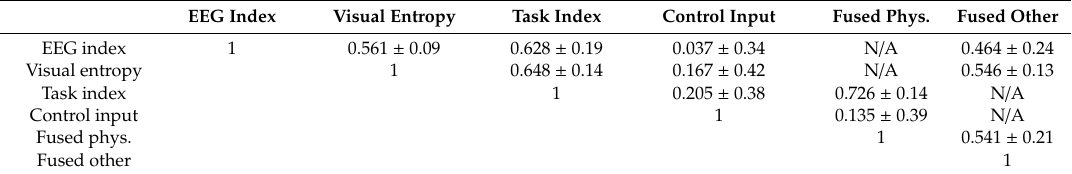
Table 5. All feature comparison. Mean and respective standard deviation across all